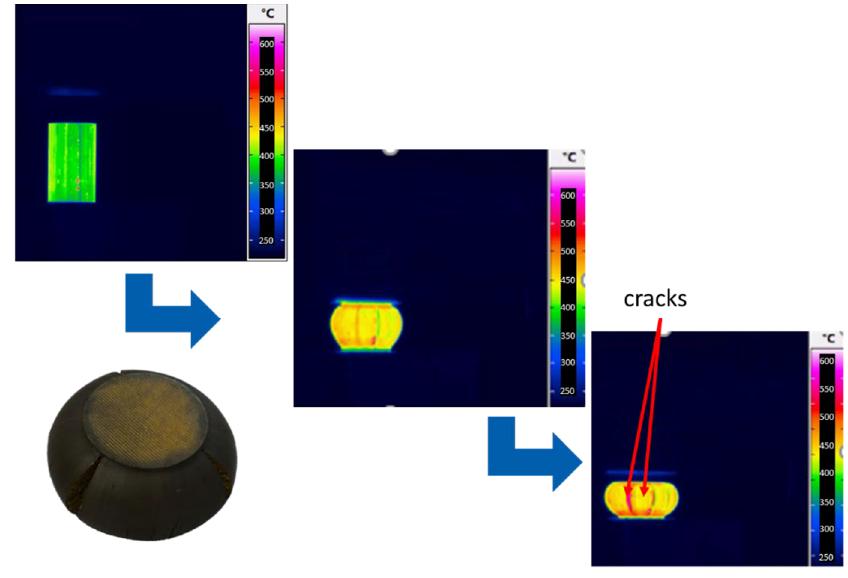
Figure 5. Upsetting process of CuZn39Pb3 with IR camera, start temperature: 450 °C. In the case of AlSi1MgMn, the upsetting temperature was lowered step by step from 500 °C onwards. During the upsetting tests with an initial temperature of 200 °C, cracks appeared that can be clearly seen with the IR camera (see Figure 6).